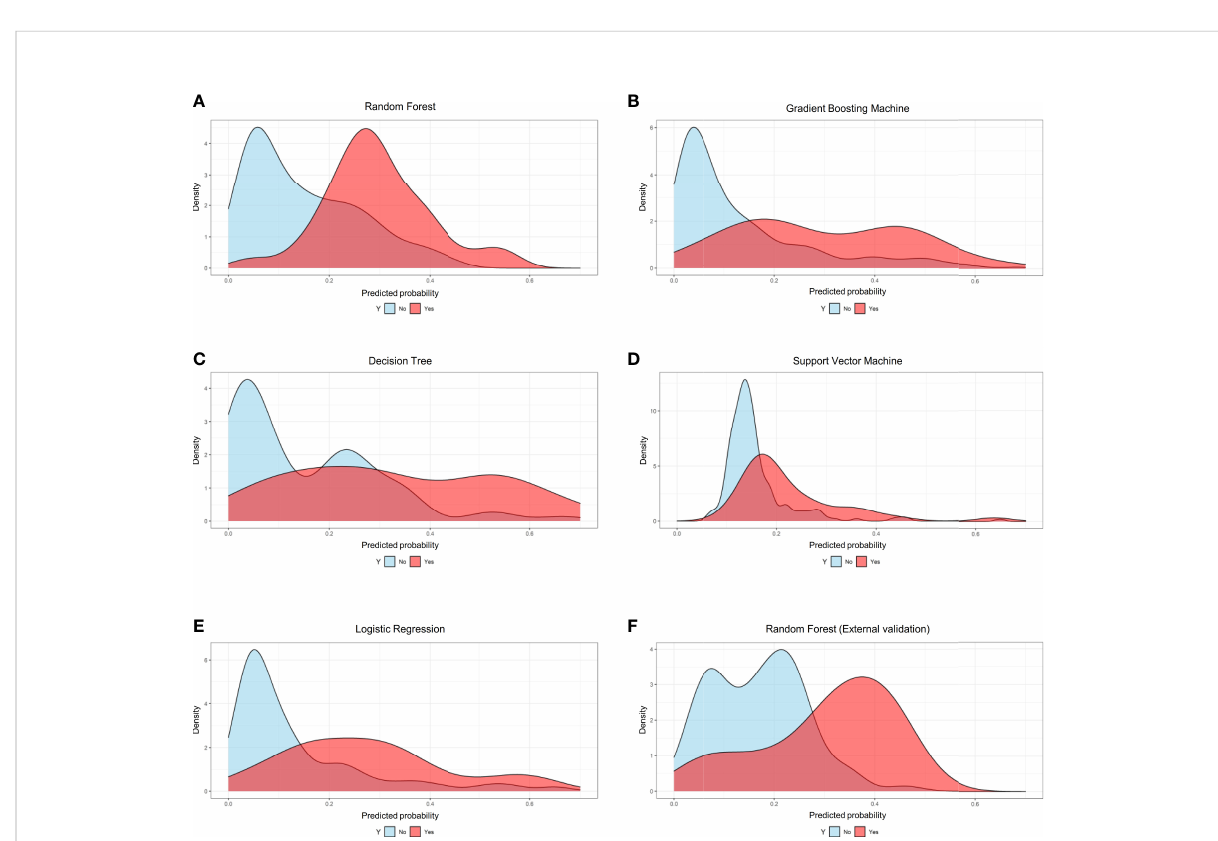
FIGURE 4 Probability curves for the machine learning-based models. (A) Random Forest for internal validation; (B) Gradient Boosting Machine; (C) Decision Tree; (D) Support Vector Machine; (E) Logistic Regression; (F) Random Forest for external